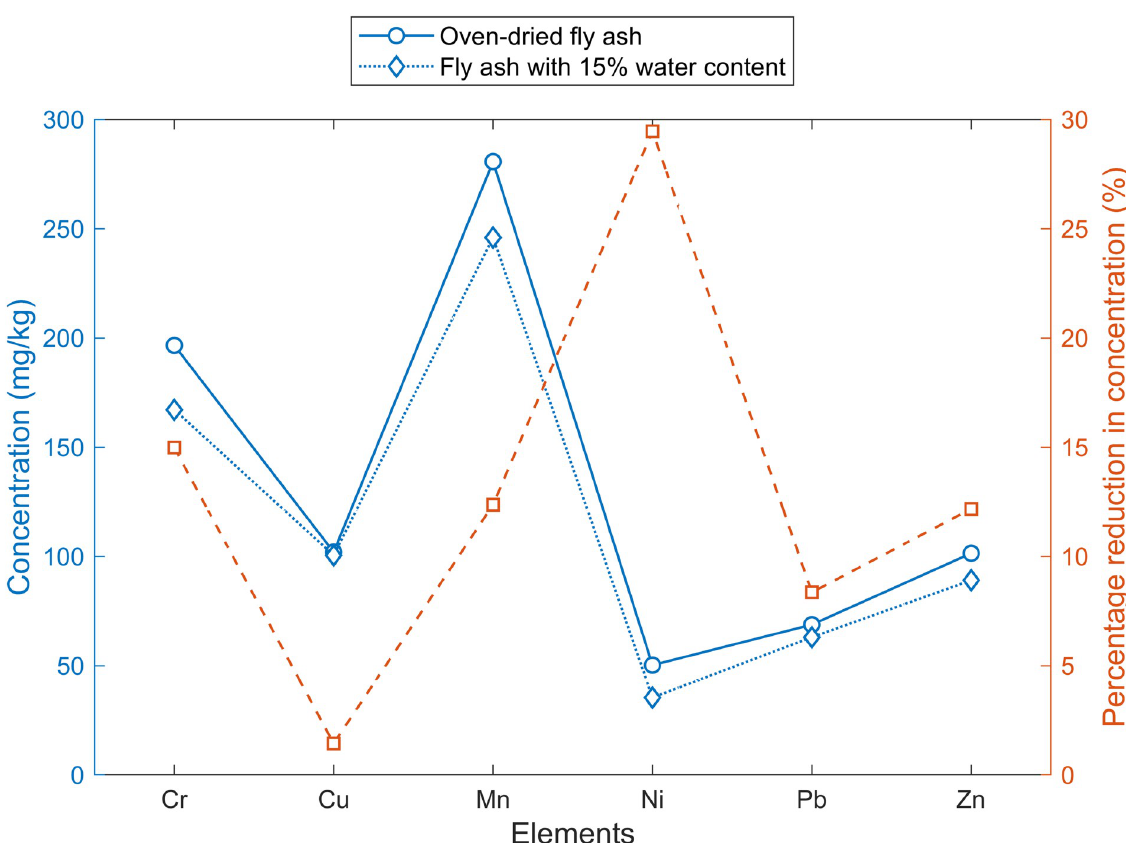
Fig 5. Comparison of elemental concentration in fly ash with water content = 15% and oven-dried fly